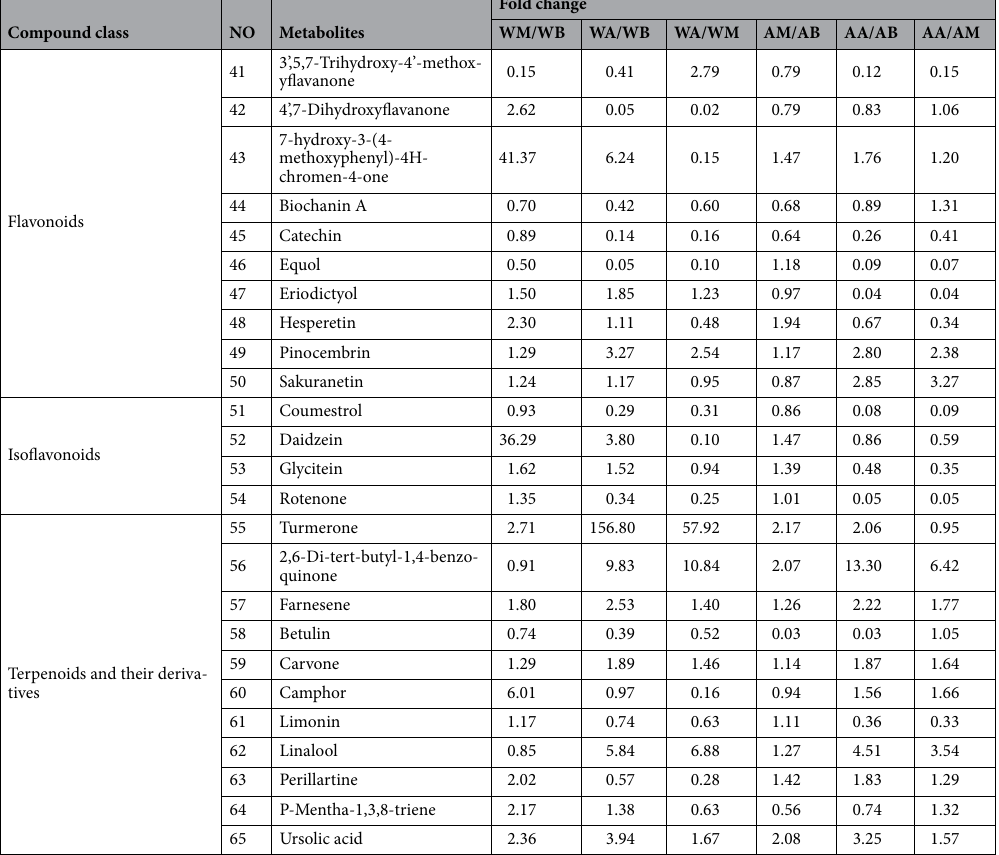
Table 2. Summary of sterols, phenols, flavonoids, and terpenoids metabolites were annotated in Inonotus hispidus. WM/WB: The ratio of the mature period to budding period of wild Inonotus hispidus . WA/WB: The ratio of the mature period to budding period of wild Inonotus hispidus . WA/WM: The ratio of the aging period to mature period of wild Inonotus hispidus. AM/AB: The ratio of the mature period to budding period of artificially cultivated Inonotus hispidus . AA/AB: The ratio of the aging period to budding period of artificially cultivated Inonotus hispidus . AA/AM: The ratio of the aging period to mature period of artificially cultivated Inonotus